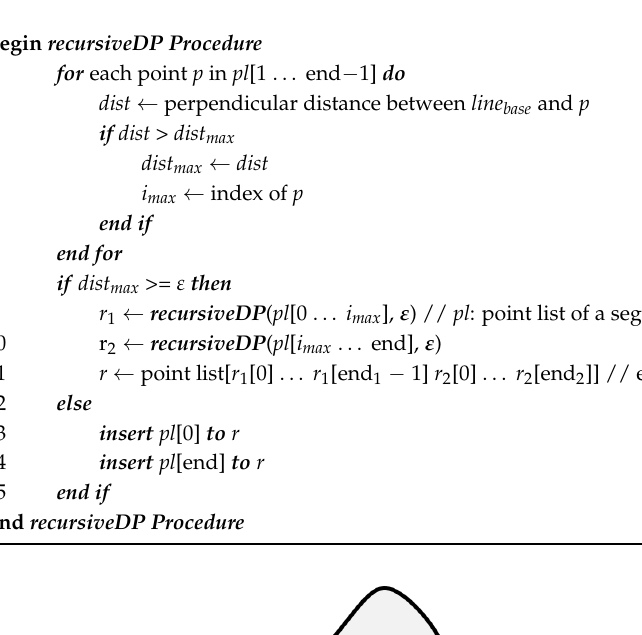
Algorithm 2. Cont.